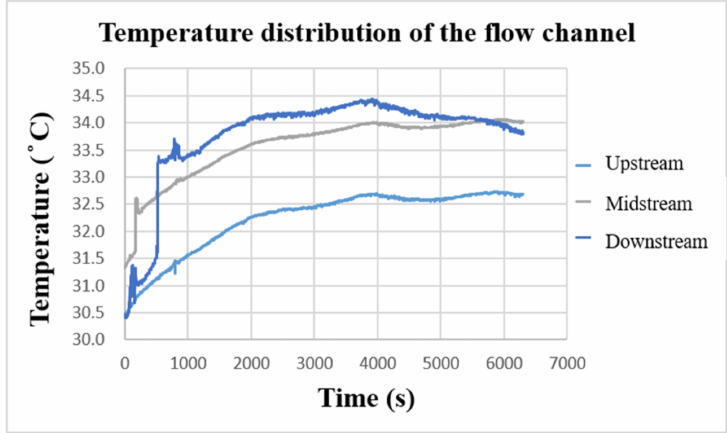
Figure 17. Charge-temperature curve of flow